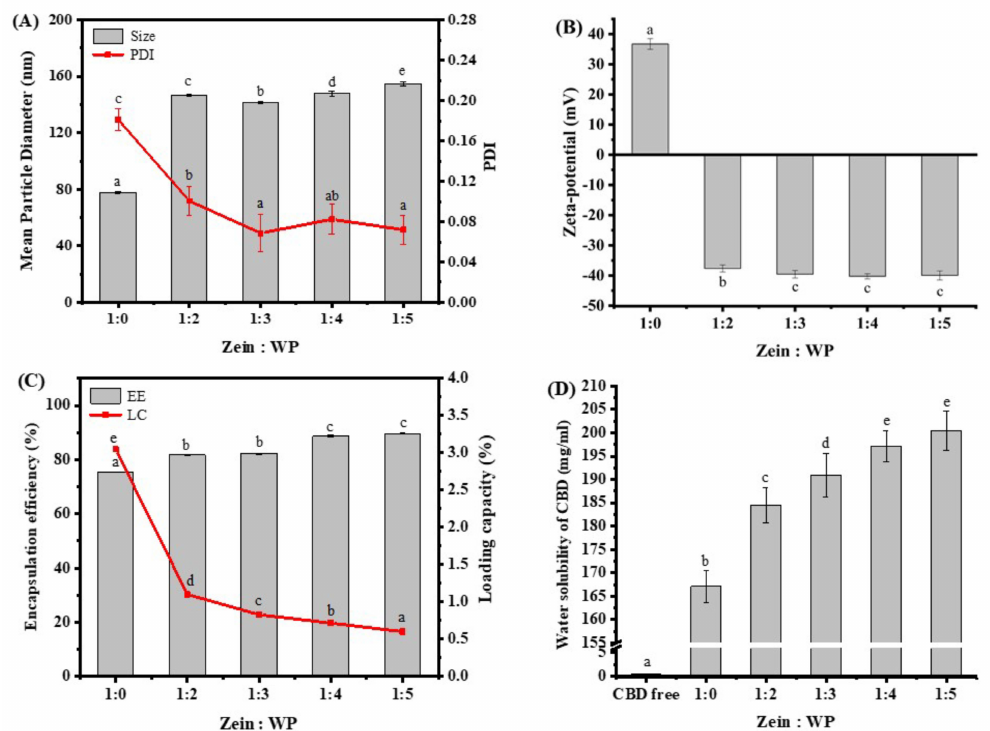
Figure 2. Mean particle diameter, polydispersity index (PDI) ( A ), and zeta-potential ( B ) of nanoparti- cles at zein:WP ratios of 1:0 to 1:5. Encapsulation efficiency (EE), loading capacity (LC) ( C ), and water solubility ( D ) of CBD in nanoparticles at zein:WP ratios of 1:2 to 1:5. Note: Different lowercase letters indicate the significant difference ( p < 0.05) between samples at different biopolymer